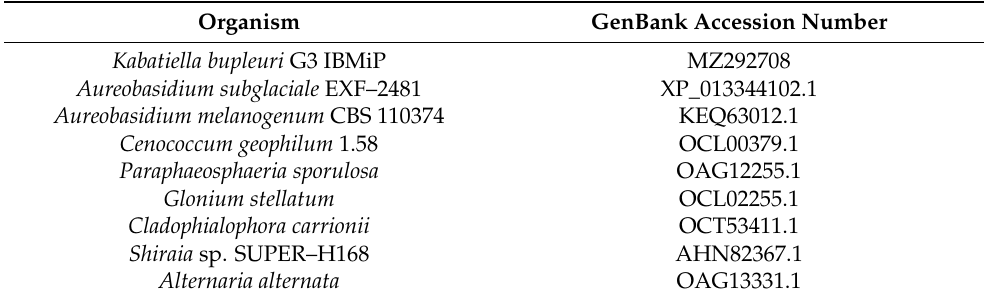
Table 1. Accession numbers of sequences of laccases produced by Ascomycetes used for multiple sequence